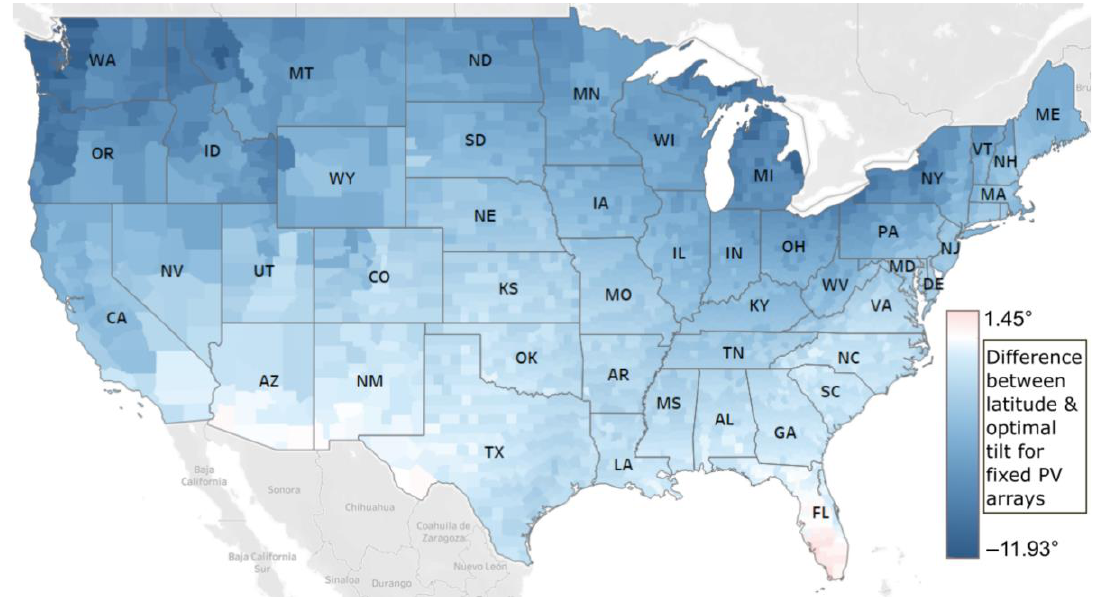
Figure 6. Calculated difference between optimal tilt angle and location latitude.